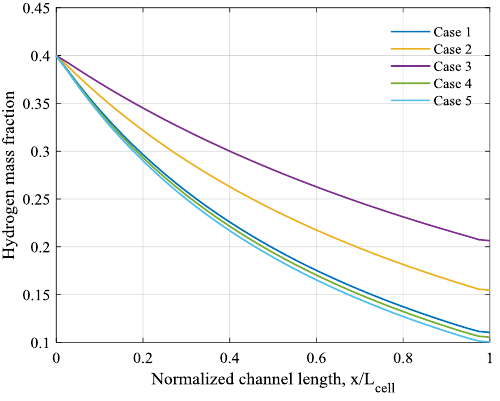
Figure 5. Hydrogen mass fraction variation along the normalized fuel channel length.